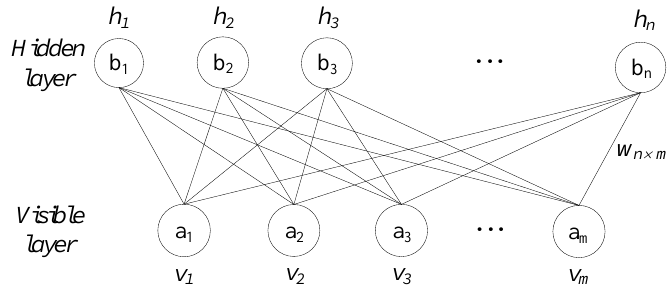
Figure 5. The structure of the restricted Boltzmann machine